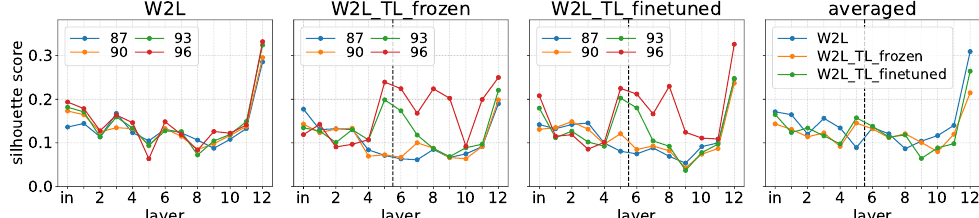
Figure 5. Silhouette scores at different distance thresholds. Through transfer learning, models W2L_TL_frozen and W2L_TL_finetuned are expected to have best phoneme encoding in layer 5. Transition from pre-trained layers to added layers is indicated by a vertical dashed